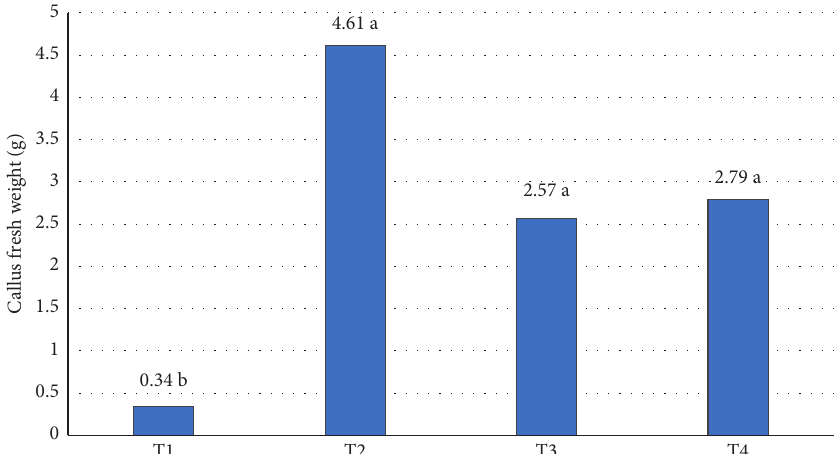
Figure 1: Weight of EMS-treated calli after culture on MS medium +15% PEG for 6 weeks. T 1: non-EMS-treated calli; T 2: calli treated with 10mM EMS for 2 h; T 3: calli treated with 10mM EMS for 4 h; and T 4: calli treated with 16mM EMS for 4h.